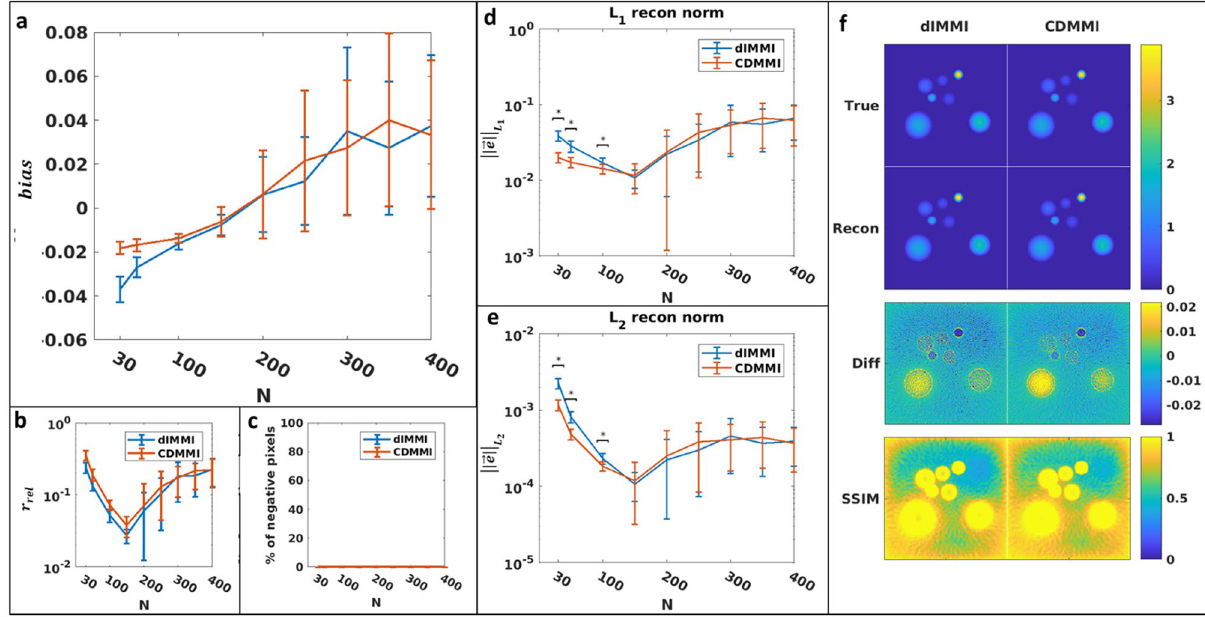
Figure 5. Comparison of dIMMI- and CDMMI-based reconstructions using the nnAPCG reconstruction algorithm. ( a ) Both models tend towards increasing absolute error as a function of image size though ( b ) the relative residual for CDMMI is higher than dIMMI for low image resolutions, converging at higher resolutions. ( c ) Neither model incurs negative pixels due to the non-negative constraint. When considering the reconstruction L 1 norm ( d ) and L 2 norm ( e ) for each model, CDMMI results in a lower norm at low resolutions; again, both methods perform similarly at high resolutions. ( f ) depicts the ground truth, reconstructed, difference, and SSIM images for each of the methods. Both models underestimate the true image intensity for high-intensity objects when reconstructed using nnAPCG, causing mismatches towards the center of each object. Figure created using a combination of MATLAB and Microsoft